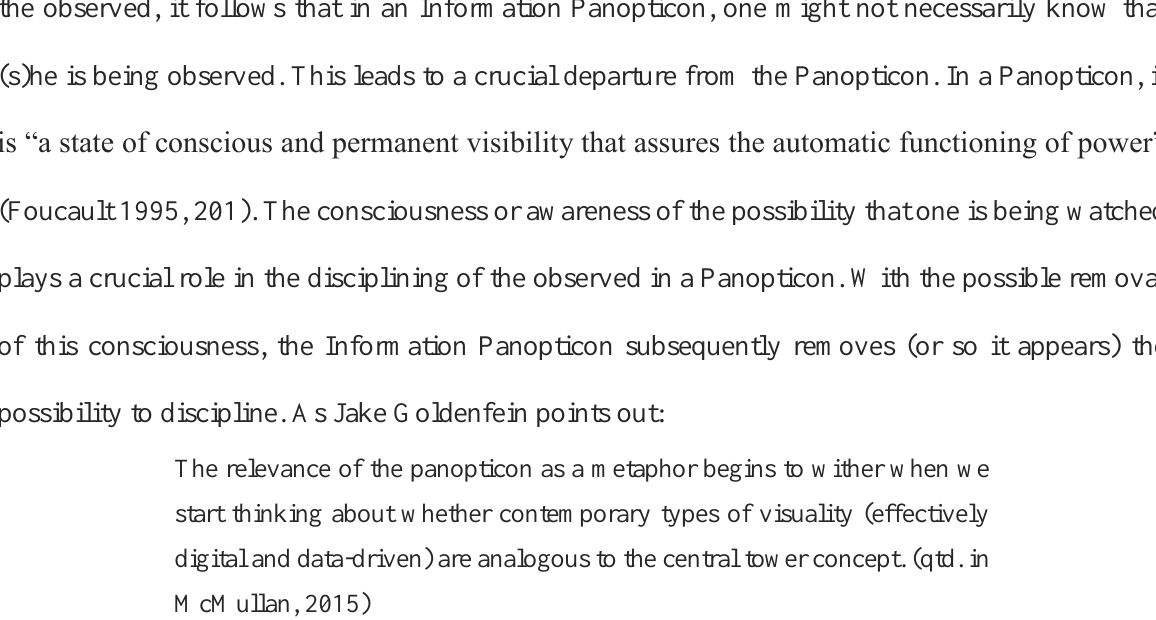
CINEJ Cinema Journal: Panoptic Pranksters: Power, Space and Visibility in the Information Panopticon in Scare